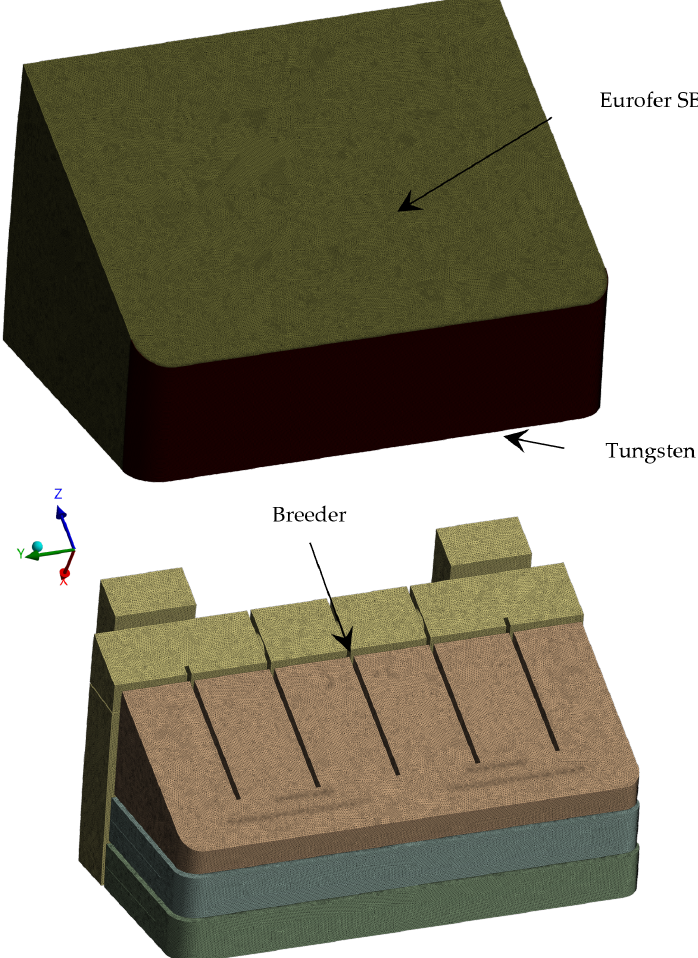
Figure 14. Breeder, SB and tungsten spatial